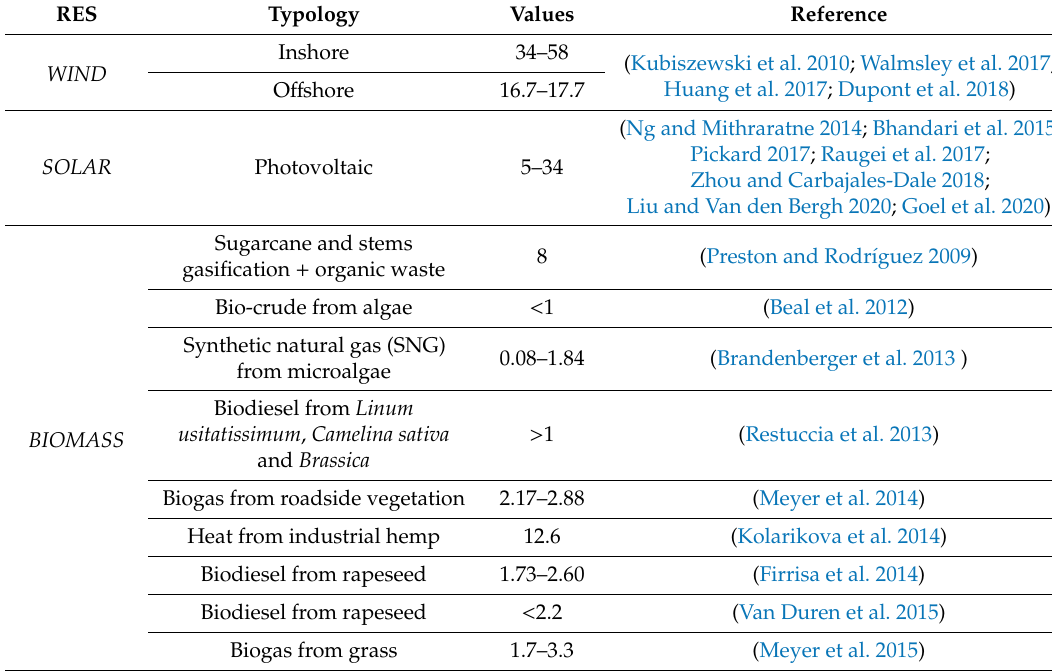
Table 1. Renewable energy sources and energy return on energy invested EROEI